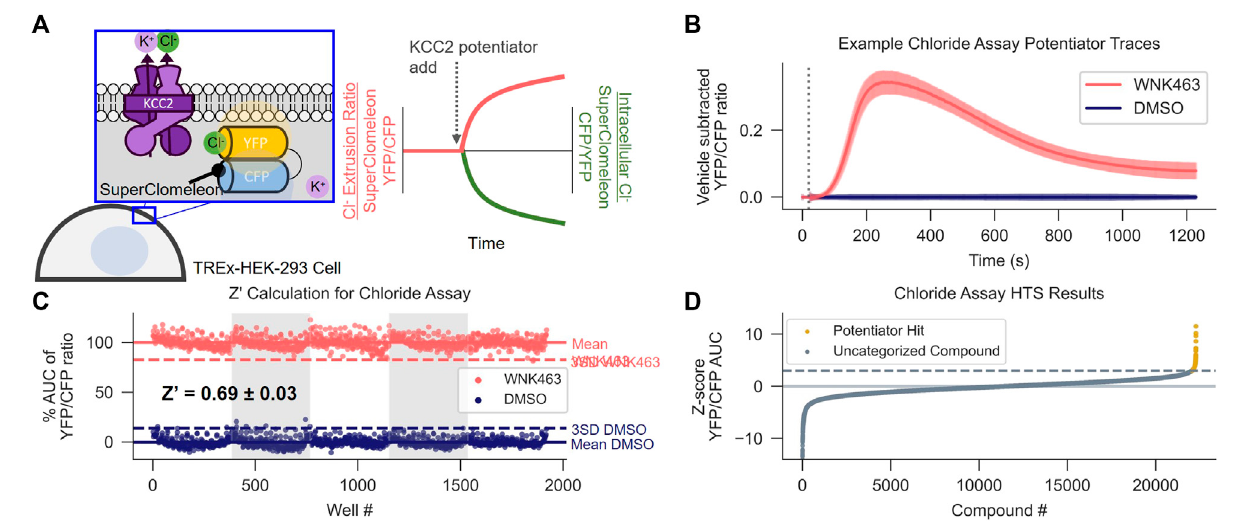
FIGURE1| DiscoveryofKCC2PotentiatorsbyHigh-throughputScreening. (A) Cl − fl uxassayschematicanddatanormalization.KCC2activityisapproximatedby measuring intracellular Cl − using HEK-293 cells overexpressing KCC2 and the Cl − sensor SuperClomeleon. Data are normalized as a YFP/CFP ratio, such that an increase in KCC2 activity registers as an increase in value. (B,C) Calculation of Z ′ for the Cl − fl ux assay. (B) Vehicle control subtracted and averaged traces from the Cl − fl uxassayusedforZ ′ calculation.CellsweretreatedwitheithertheindirectKCC2potentiatorWNK463orDMSOcontrol.Errorbarsrepresentstandarddeviationof the mean (SD). (C) Percent Area Under the Curve (AUC) of Cl − fl ux assay traces in (B) . The mean AUC (solid line) and three x SD away from mean AUC (dotted line) are displayed for each treatment ( n = 192). (D) Results of screening approximately 23,000 unique compounds at a concentration of 10 µM in the Cl − fl ux assay. Data are presented as Z-scores relative to vehicle control values on each plate. A Z-score of 3 (dotted line) was used as a cut off for separating potentiator hits (gold) from uncategorized compounds (gray). All experiments were performed at 37 ° C.